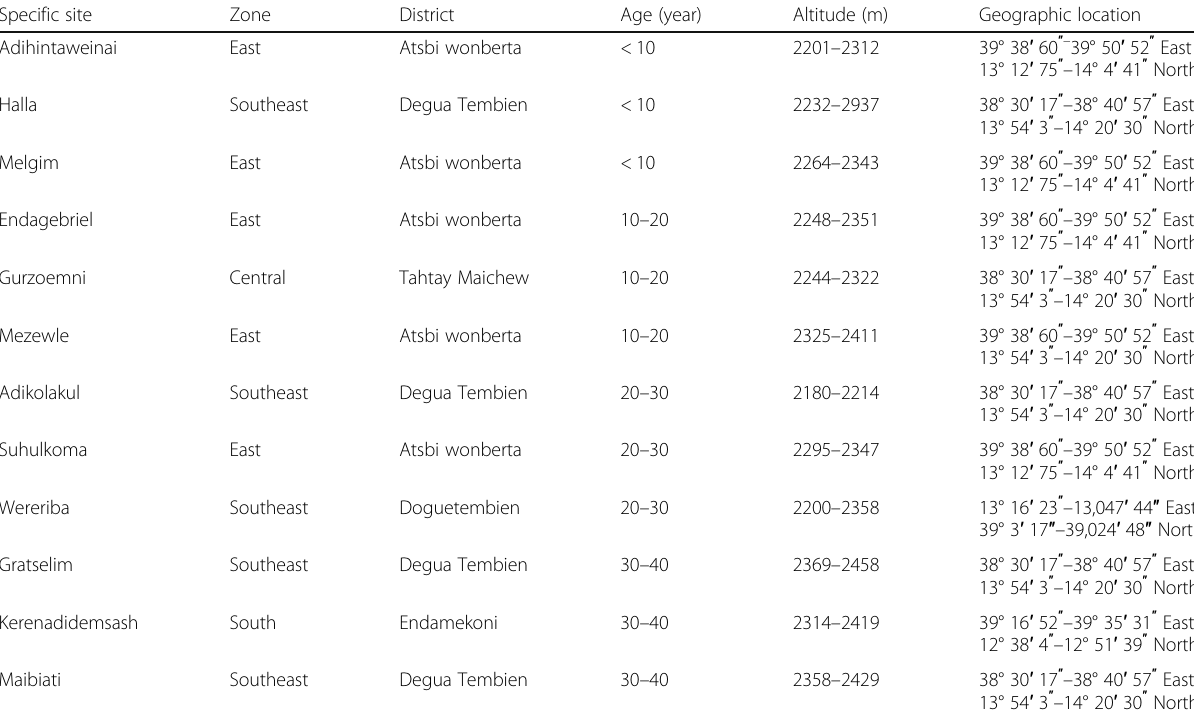
Table 1 Specific study site age, altitude and geographic location